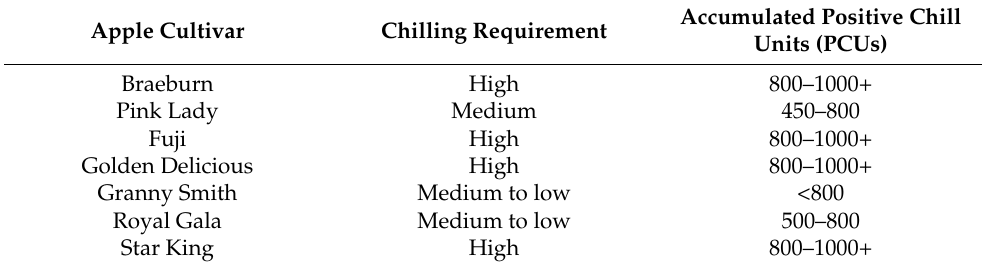
Table 1. Chilling requirements of selected apple cultivars